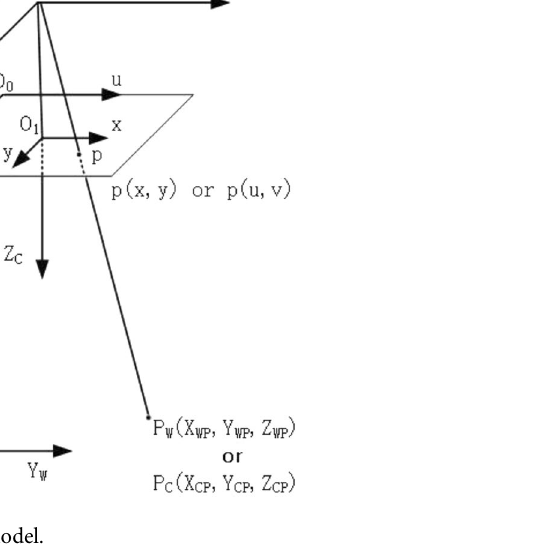
Figure 1. Monocular camera